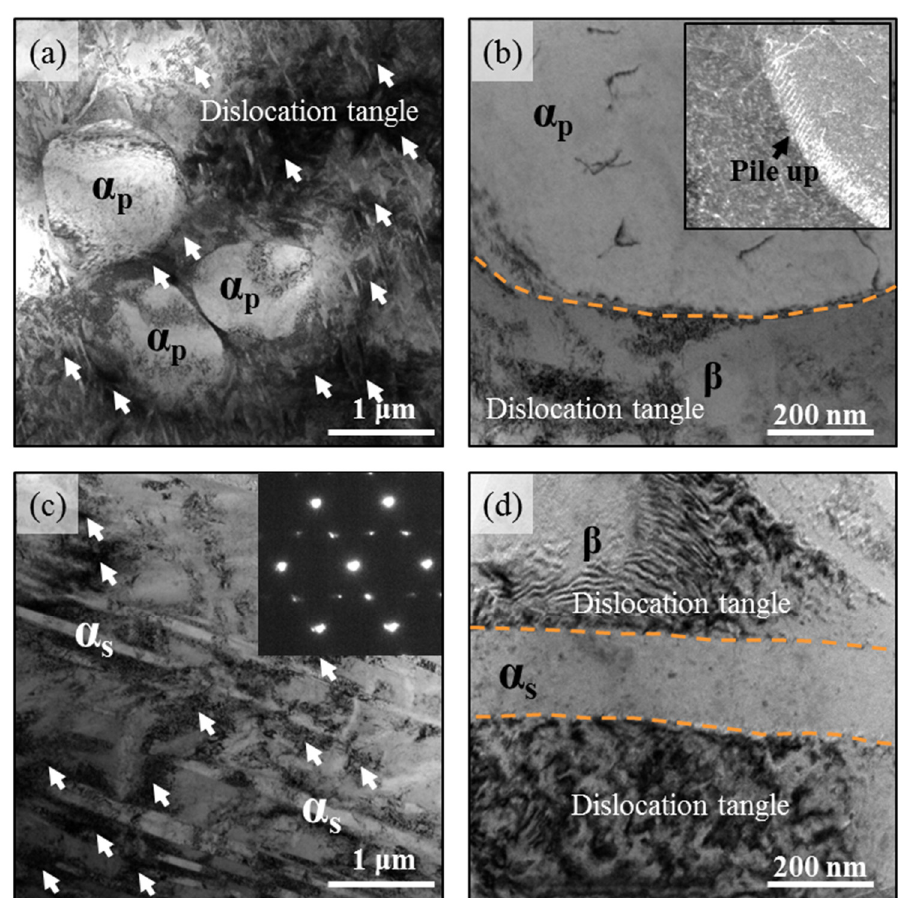
Figure 7. Deformation micromechanisms in two kinds of α - β metastable β -Ti alloys at quasi-static loading. ( a ) Bright field TEM image of deformed α p,s + β Ti-45551 and its details ( b ); ( c ) bright field TEM image of deformed α s + β Ti-45551 and its details ( d ). The white arrows represent dislocation